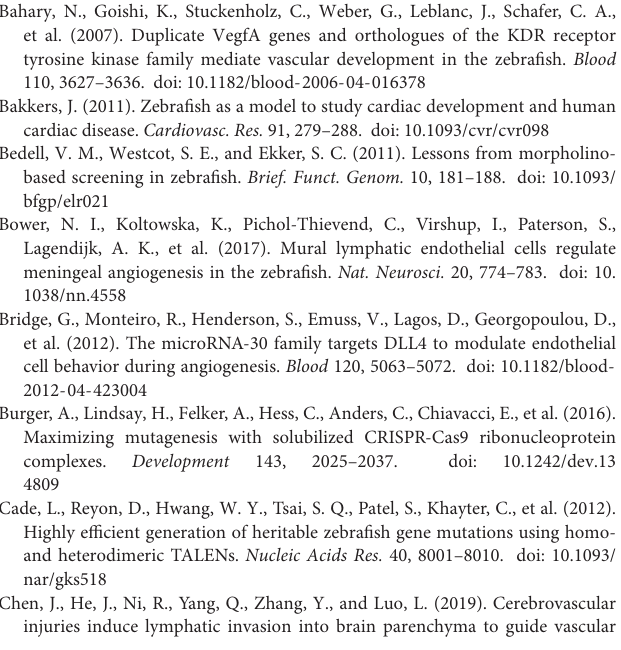
the stop codon. (B,C) Sequence alignment of part of exon 1 from the ccbe1 + / + and ccbe1 lri 97 / lri 97 allele shows CRISPR-induced indels (B) . A six-nucleotide deletion (CTTTCC) and a one-nucleotide insertion (G) in the ccbe1 lri 97 / lri 97 allele were confirmed by the sequence chromatograms of the PCR products generated using ccbe1 + / + and ccbe1 lri 97 / lri 97 fish genomic DNA as templates (C) . Red lines in the sequence chromatograms indicate the CRISPR-induced nucleotide changes between ccbe1 + / + and ccbe1 lri 97 / lri 97 fish (C) . (D) HRMA used to determine the ccbe1 lri 97 genotypes. Melting curves for 2–3 independent fish of each genotype are shown in different colors as indicated in the panel. Supplementary Figure 3 | Target design and validation of kdr crRNAs. (A) Three synthetic crRNAs were designed to target sequences within exon 1 (E1), E3, and E5 on the kdr genomic locus. (B) Predicted domain structure of zebrafish Kdr. Kdr consists of a signal peptide (SP), seven immunoglobulin-like domains (Ig), a transmembrane domain (TM), and two tyrosine kinase domains (TyrKc). Arrows indicate the approximate positions of the protein sequences corresponding to the target sequences of the three designed crRNAs. (C–E) HRMA used to validate the efficacy of the three designed crRNAs. The melting curves of 6 independent embryos injected with the dgRNP complex containing kdr crRNA1 ( C, pink), crRNA2 ( D, orange), or crRNA3 ( E, purple) are presented. The melting curves of 2 independent, uninjected ( C–E, blue) and Cas9-injected ( C–E, green) sibling embryos are also presented for comparison for each crRNA. Injection of each dgRNP cocktail disrupted the corresponding target genomic sequences. Supplementary Figure 4 | Verification of each designed crRNA’s target sites and PAM sequences within the genome of the fish line used for phenotypic quantifications. The sequence chromatograms of the PCR products that were generated using Tg(kdrl:EGFP);Tg(kdrl:NLS-mCherry; A–C,J–L, and M–O ) or Tg(fli1: nEGFP );Tg(lyve1: DsRed ; D–I ) fish genomic DNA as templates. A sequence chromatogram of the individual crRNA’s target sites (yellow) and PAM sequences (pink) in the genomes of the corresponding fish line is presented. All of the designed crRNAs’ target sites and PAM sequences were perfectly matched to those in the fish lines used for quantifications in this